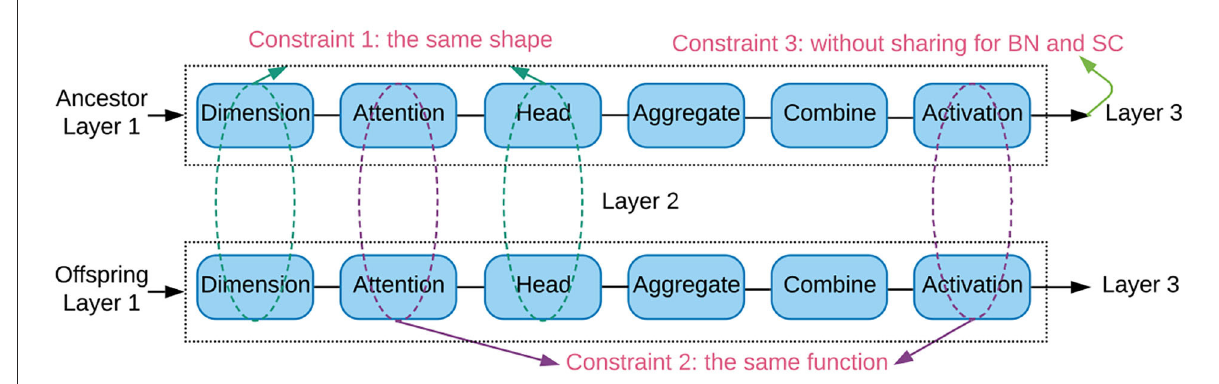
FIGURE2 Illustration of the constrained parameter sharing strategy between the ancestor and offspring architectures in layer 2. The trainable weights of a layer are shared when they have the same shapes (constraint 1), attention and activation functions (constraint 2). Constraint 3 avoids sharing in the batch normalization (BN) and skip connection